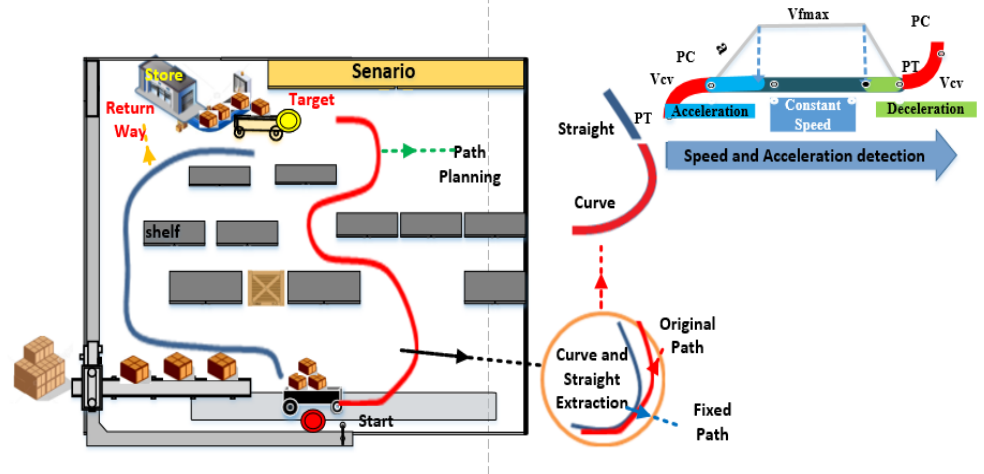
Figure 10. Speed acceleration application motion and operations.